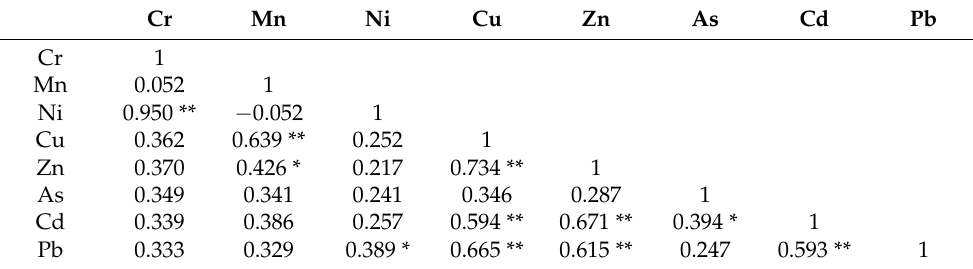
Table 6. Coefficients of correlation between heavy metals in dust fall.